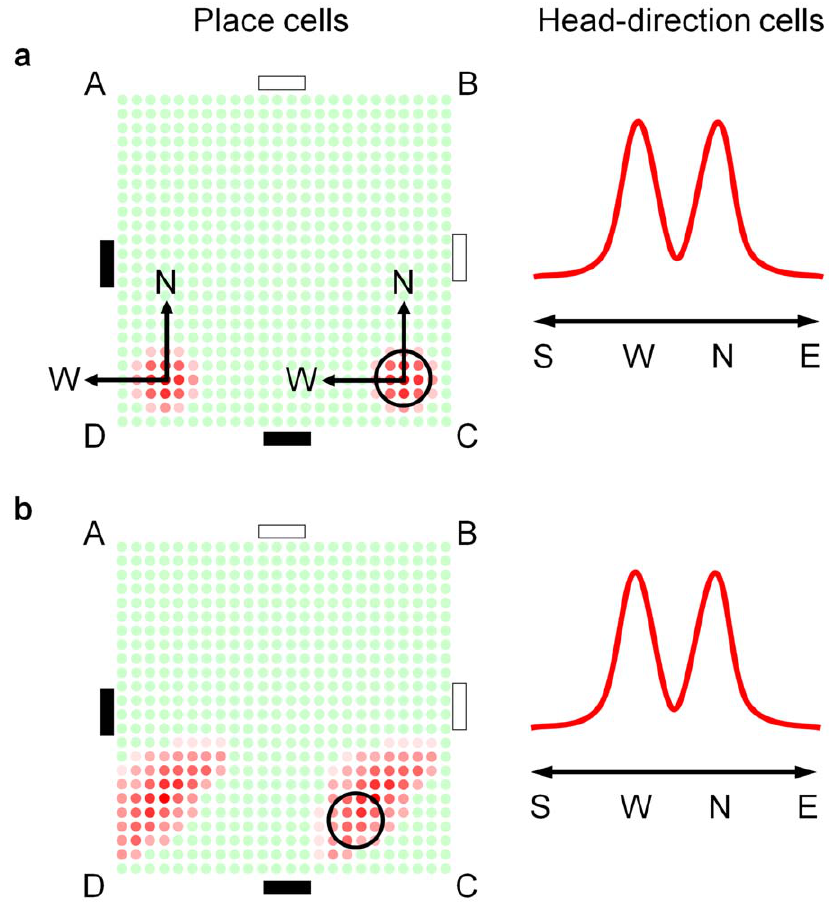
Figure 11. Hypothetical propagation of firing profiles of head-direction and place cells in the corridor arena. (a) The head-direction and place cell firing profiles that would be required to represent the multiple pose hypotheses for a rat placed at corner C facing towards corner D. The mesh of place cells is arranged to cover the entire experimental arena, with each place cell positioned in the location it encodes. The (N)orth and (W)est arrows show the two orientation estimates encoded by the head-direction cells, superimposed on the place cells. Without a conjunctive representation, there is no way to encode which orientation estimate is associated with each location estimate. (b) One possible propagation of place cell firing during movement from C to D without spatial memory binding between head-direction and place